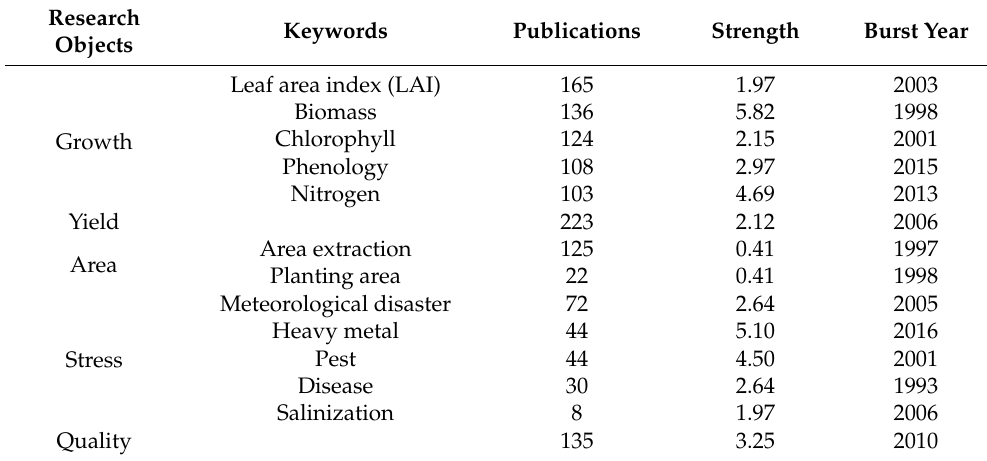
Table 5. The hot spots of rice remote sensing from the perspective of research objects.